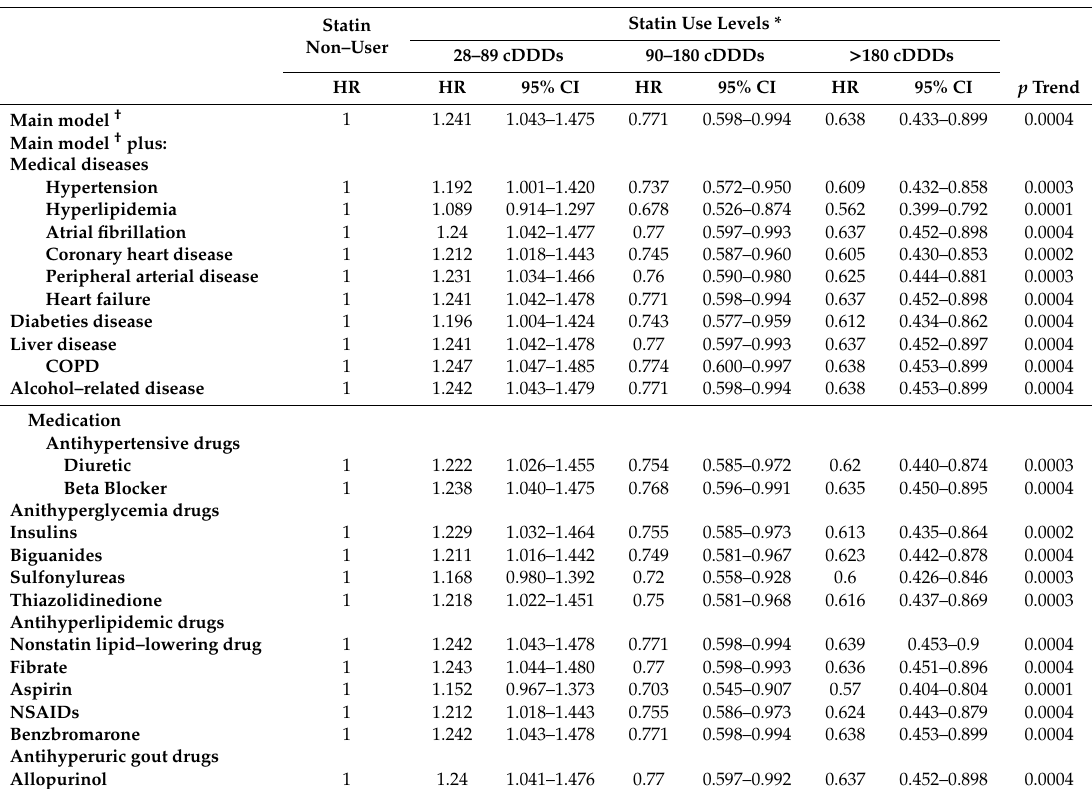
Table 9. Sensitivity analysis